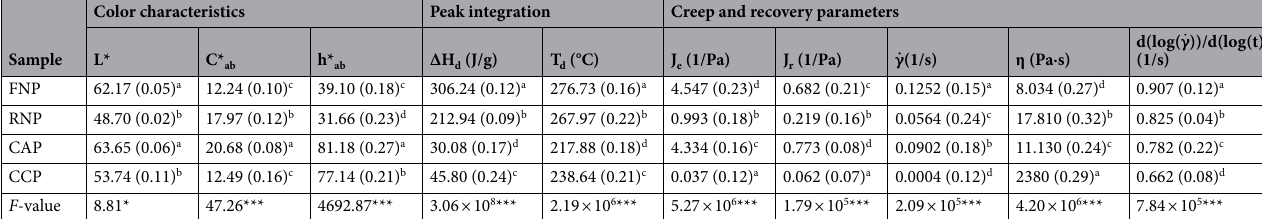
Table 4. Color characteristics, thermal properties, creep and recovery parameters of pectin samples. Mean values and standard deviation, in brackets. ns, p > 0.05, * p < 0.01, ** p < 0.001, *** p < 0.0001, a–d different letters in the same column indicate significant differences among samples ( p < 0.0001) according to the LSD test with α = 0.05. FNP, Fetească Neagră pectin; RNP, Rară Neagră pectin; CAP, commercial apple pectin; CCP, commercial citrus pectin; L*, lightness of the color; C* ab , chroma; h* ab , hue angle; ΔH d , degradation enthalpy; T d , degradation temperature; J e , equilibrium compliance; J r , recoverable compliance; ˙ γ , shear rate; η,